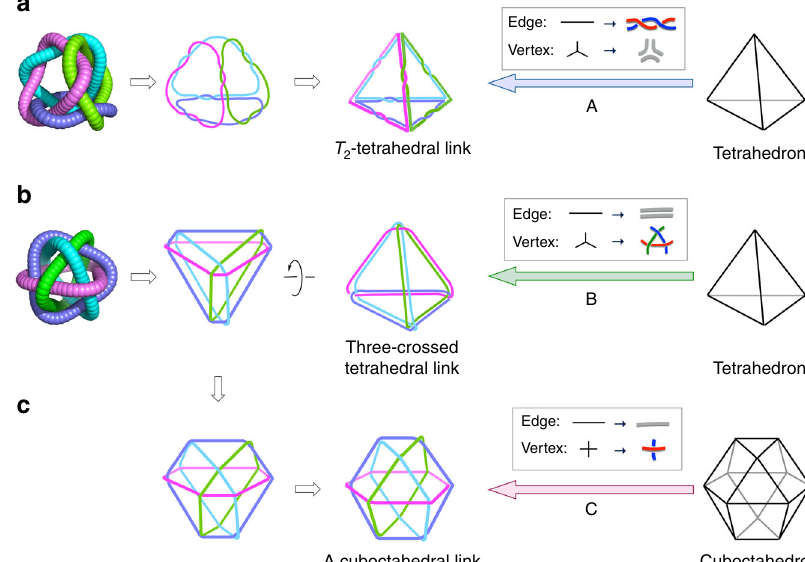
Fig. 5 Illustrations of the two [4] 12 -catenane topologies. a Topology of [4] 12 -catenane 2 constructed from a tetrahedron through method A, in which each edge is converted to T 2 -double lines and each vertex to three separated lines. b Topology of [4] 12 -catenane 4 constructed from a tetrahedron through method B, in which each edge is converted to two separated lines and each vertex to three-crossed lines. c Another topological description of 4 , in which it is constructed from a cuboctahedron through method C. Each edge is retained as a single line and each vertex converted to a raised intersection. Note that the direction of each loop in this fi gure is not shown